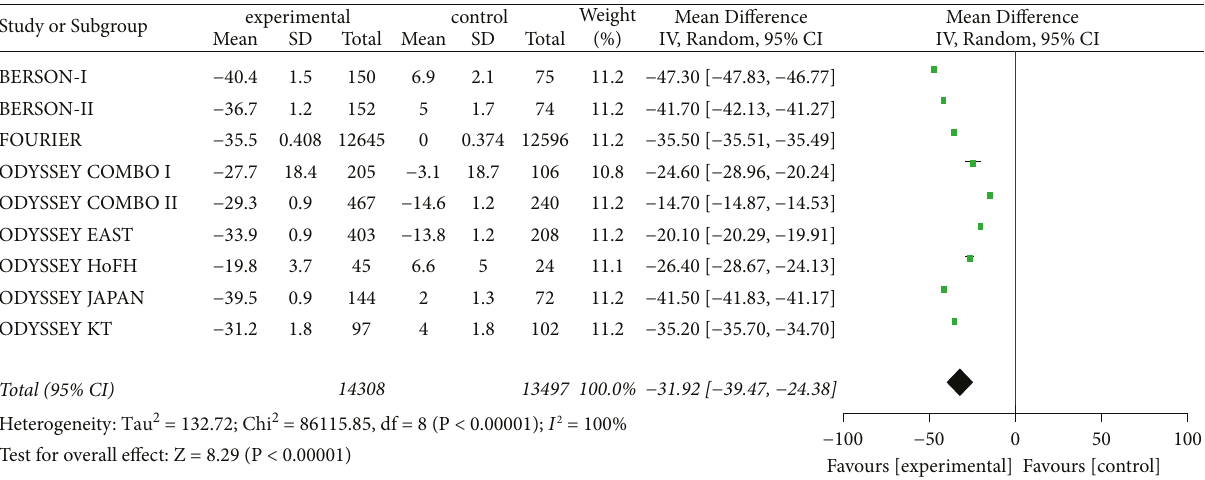
Study or Subgroup